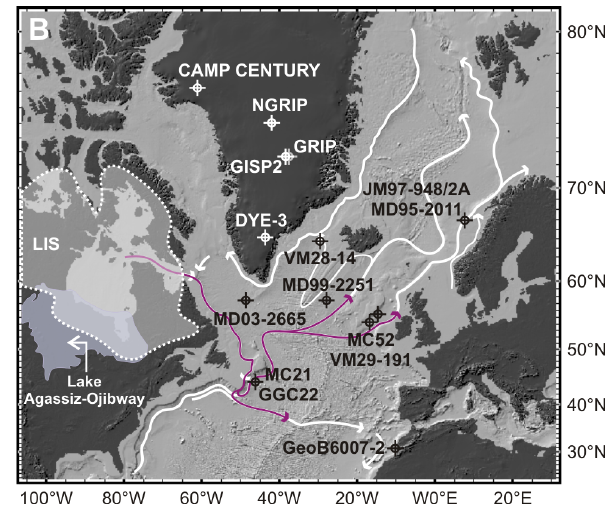
Figure 1b. Core sites mentioned in the text in relation to the modern (sub)surface-current system in the northern North Atlantic Ocean and the Nordic Seas (same as in Fig. 1a to the left) (Orvik and Niiler, 2002). The purple arrows indicate the possible trajectories of floodwaters and icebergs from Hudson Bay. LIS: Laurentide Ice Sheet (marked by the dashed white line). Lake Agassiz–Ojibway is also shown (Teller et al.,